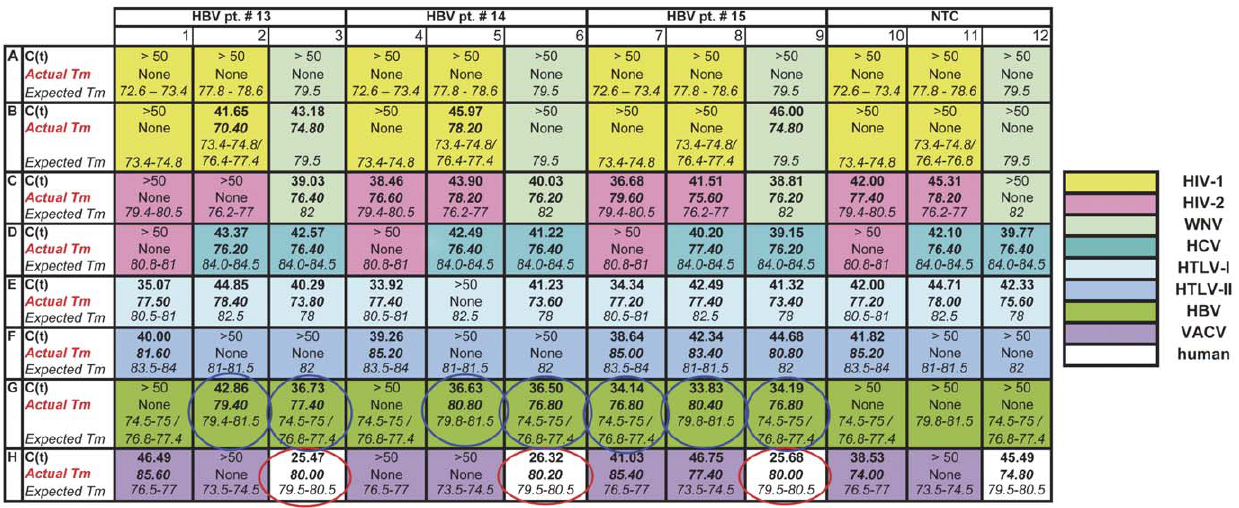
Figure 2. Evaluation of the real-time PCR array using blood samples derived from individuals infected with HBV. Three HBV positive patients’ samples (pt. # 13–pt. # 15) and one no-template control (NTC) were tested in one assay. The color scheme, shown as a footnote, refers to each virus and reflects the specific primer sets loaded into the array. Expected Tm peaks for each amplicon are shown in italic, experimentally obtained Tm peaks are shown in bold italic, and C(t) values from the experimental testing are shown in bold for each of the primer sets. The C(t) and Tm peaks that reflect the positive signals are circled: only positive signals from HBV (blue circles) and human beta-globin gene (red circles) were detected in the experiment.